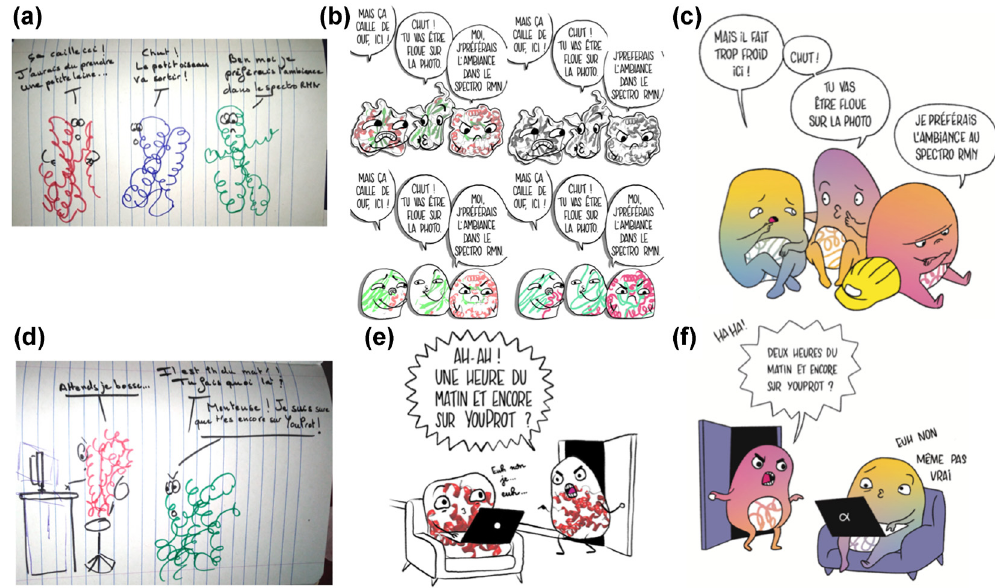
Figure 6: From scribble to publication. (a–c) Three proteins in the Cryo-EM spectrometer complain about the cold. (a) Original drawing by S. Sacquin-Mora (b) Various tests by Anmryn. (c) Final published figure by Anmryn. (d–f) some proteins spend too much time on the Internet. (d) Original drawing by S. Sacquin-Mora. (e) Test by Anmryn. (f) Final published figure of Anmryn. (Figures (c) and (f) reproduced with permission from